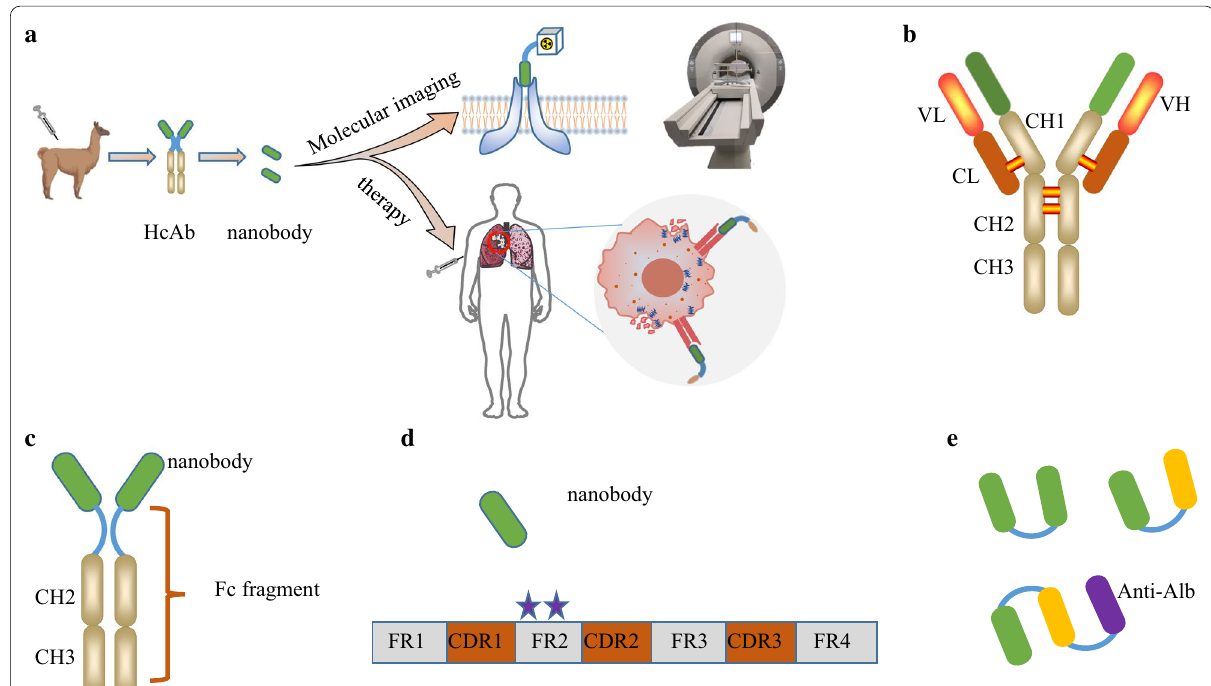
Fig. 1 Schematic illustration of mAb, HcAb, nanobody, and multivalent nanobody. ( a ) The application of nanobodies, it has a favorable role for imaging and therapy. ( b ) Classical mAb is composed of two identical light (L) chains and heavy (H) chains. Each heavy or light chain contains two functional domains, i.e., variable region (VR) and one constant region (CR). The difference is that light chain has only one constant region, whereas heavy chain has three or four constant regions. ( c ) HcAb naturally lacks light chains and CH1 domains. Its variable fragment is the nanobody. ( d ) Nanobody consists of four framework regions and three complementarity-determining regions. ( e ) Nanobodies can be produced in a bivalent format, either bivalent-monospecific or bivalent-bispecific. Furthermore, the addition of a third nanobody that binds to serum albumin (anti-Alb) can form multivalent constructs; all these formats can prolong the half-life of nanobodies in the